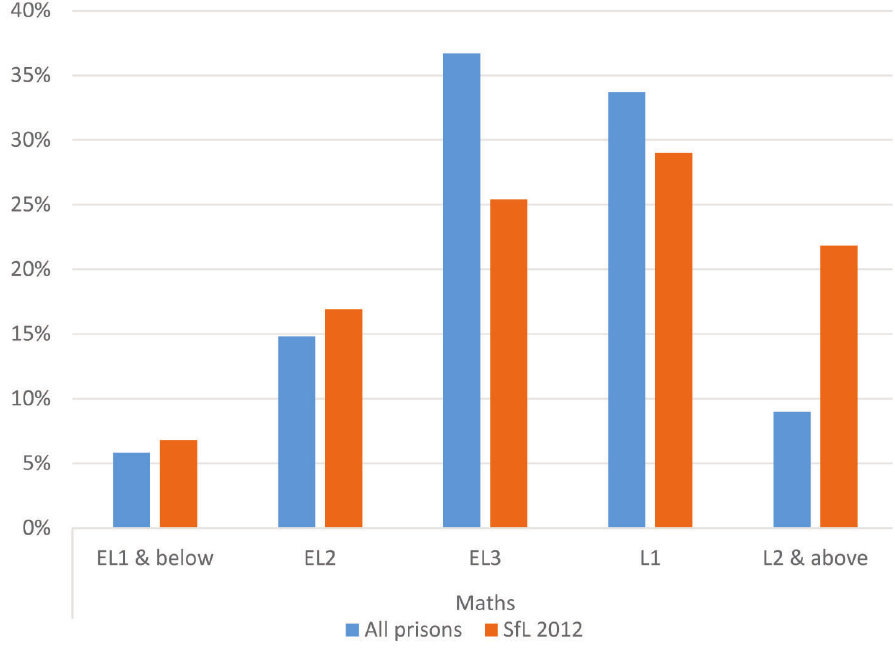
Figure 2: Prisoners’numeracylevelscomparedwiththe2011SkillsforLife(SfL)survey However,wecanseparateouttheadultmalesfromthefemaleestateandtheYOIstoseewhat impactgenderhasonskills.Figure3illustratesthat,ingeneral,femaleprisonershavemarginally